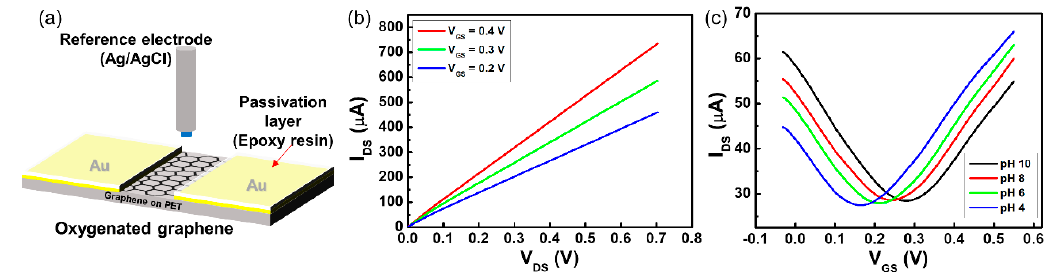
Figure 2. Typical three-dimensional pH sensor using graphene field-effect transistor. ( a ) Schematic illustration of G-ISFET with Ag/AgCl reference electrode. For oxygenated G-ISFET: ( b ) I DS – V DS transfer characteristic with respect to V GS and ( c ) I DS – V GS transfer characteristic with respect to pH value.